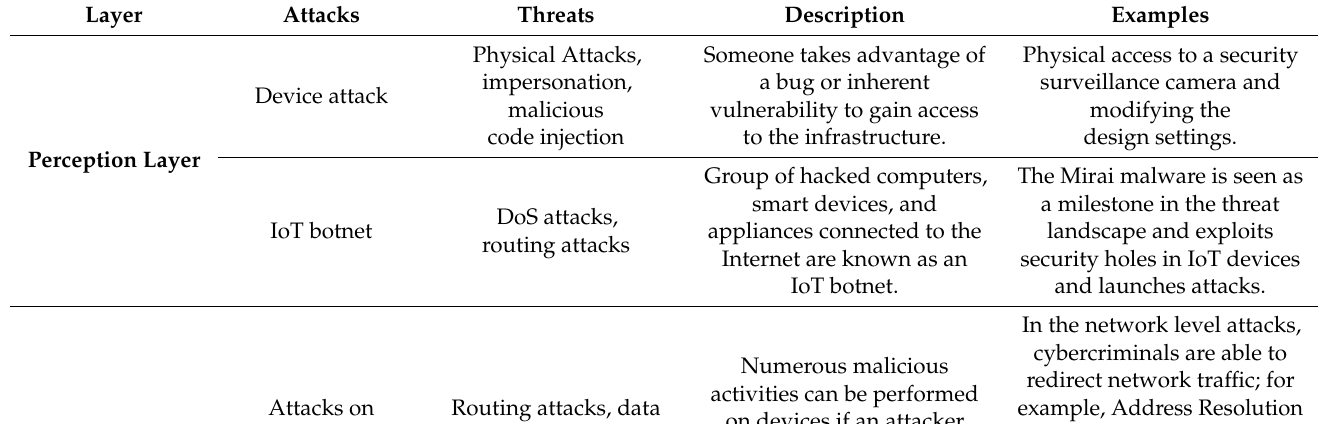
Table 2. VSS architecture layers, attacks and their